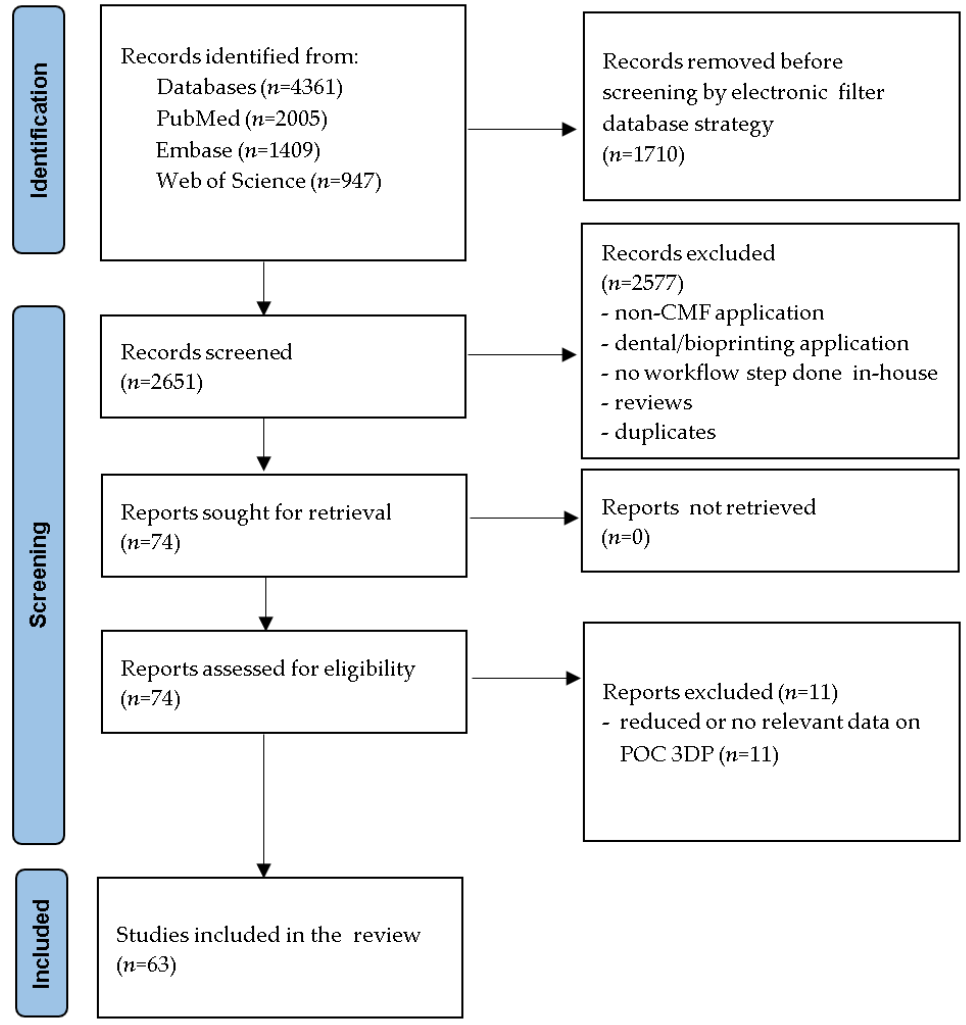
Figure 1. Schematic representation of the strategy for the selection of final articles.